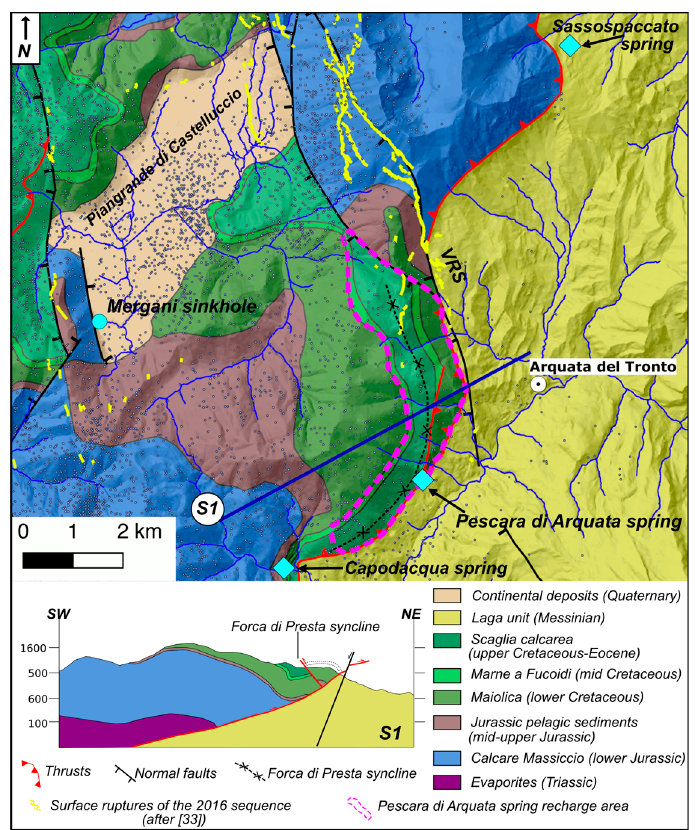
Figure 2. Hydrogeological map of the study area. Purple line delimits the Pescara di Arquata spring recharge area.